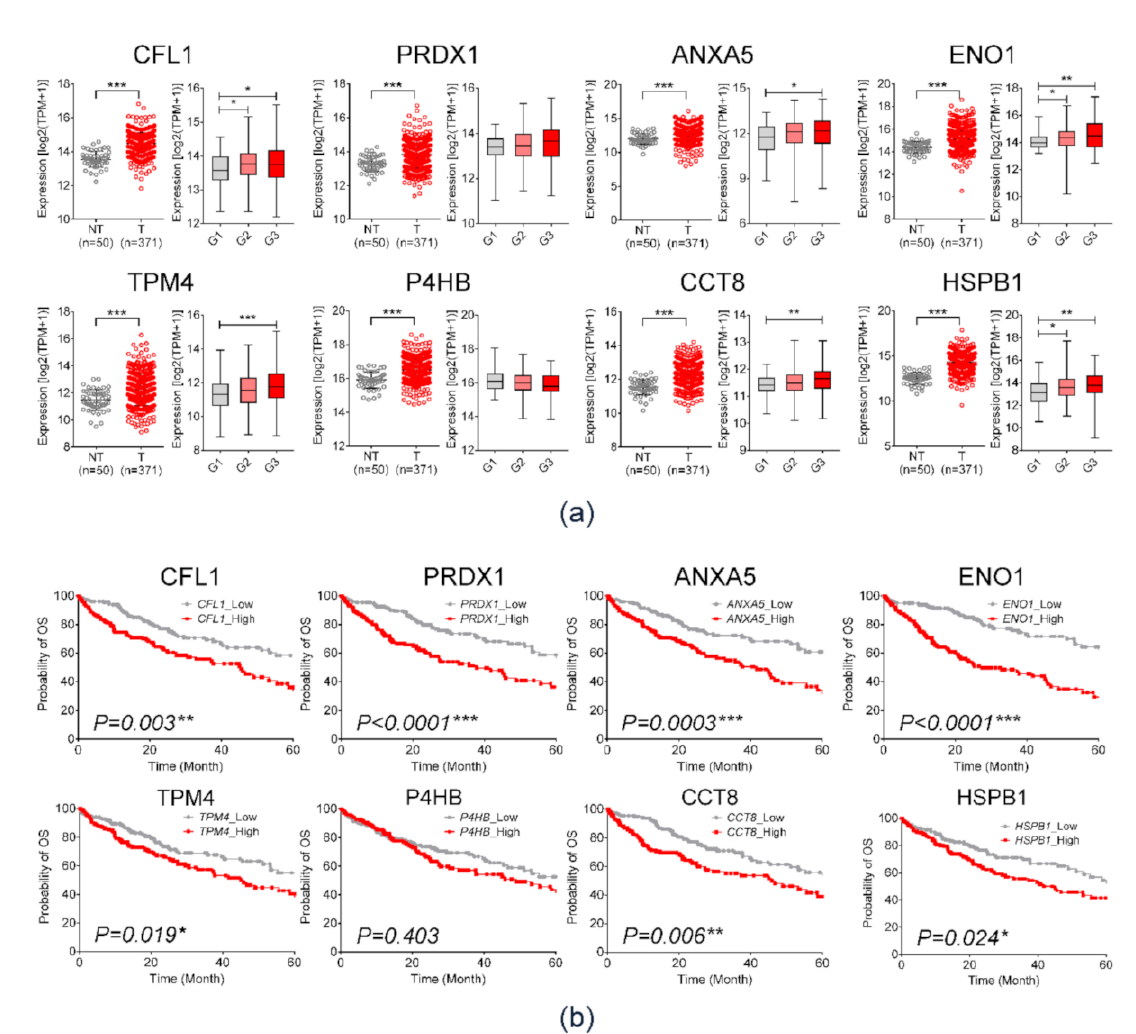
Figure 3. Validation of overexpression of eight exosomal protein markers in hepatocellular carcinoma (HCC) and its clinical relevance through TCGA_LIHC dataset. ( a ) TCGA_LIHC analysis in HCC tissues ( n = 371) compared with that in non-tumor tissues ( n = 50) (left), and expression of candidate genes according to tumor histologic grade (right). (Welch’s t -test; * p < 0.05, ** p < 0.01, *** p < 0.001) ( b ) Kaplan–Meier plot for overall survival according to mRNA expression of exosomal proteins in TCGA_LIHC. The p -value was obtained with the log-rank